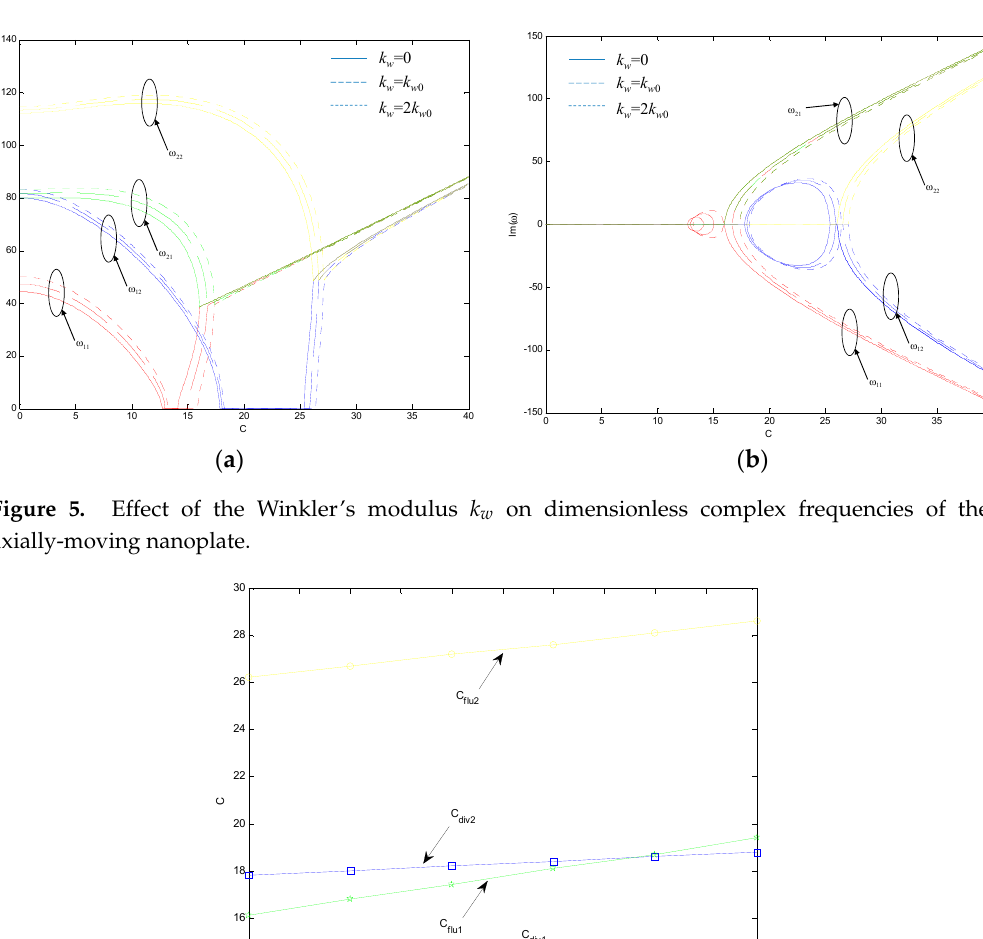
( b ) Figure 4. Dimensionless complex frequencies vs axially moving speed for the nanoplate resting on a viscoelastic foundation. From the Figures 3 and 4, it was found that the viscoelastic foundation had a significant impact on the dynamic instability of the nanoplate. So, the effects of viscoelastic foundation model parameters including the Winkler’s modulus k w , the Pasternak’s modulus k G , and the damping c t on